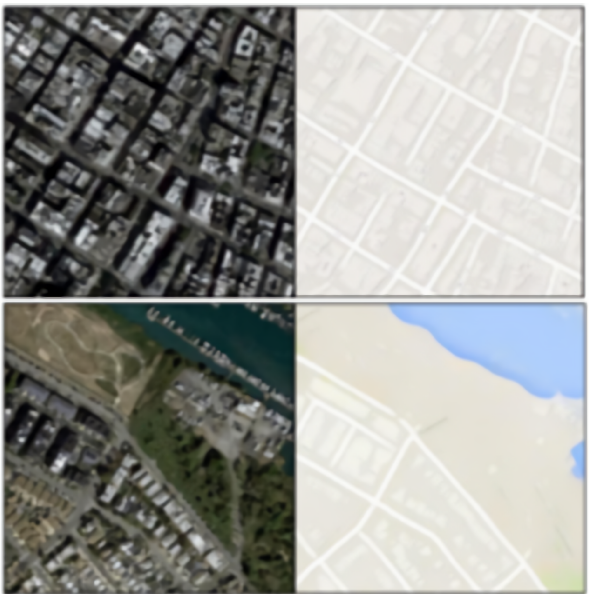
Figure 3. An example of aerial-to-map dataset of Pix2Pix images. These images were used for training and testing our models.